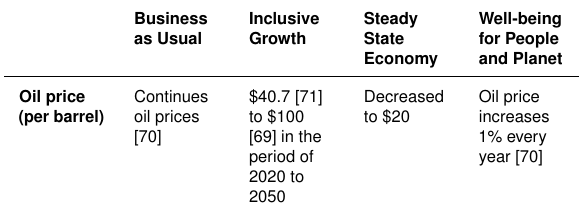
Table 9. Oil Price in different scenarios. Source: IEO (2020)